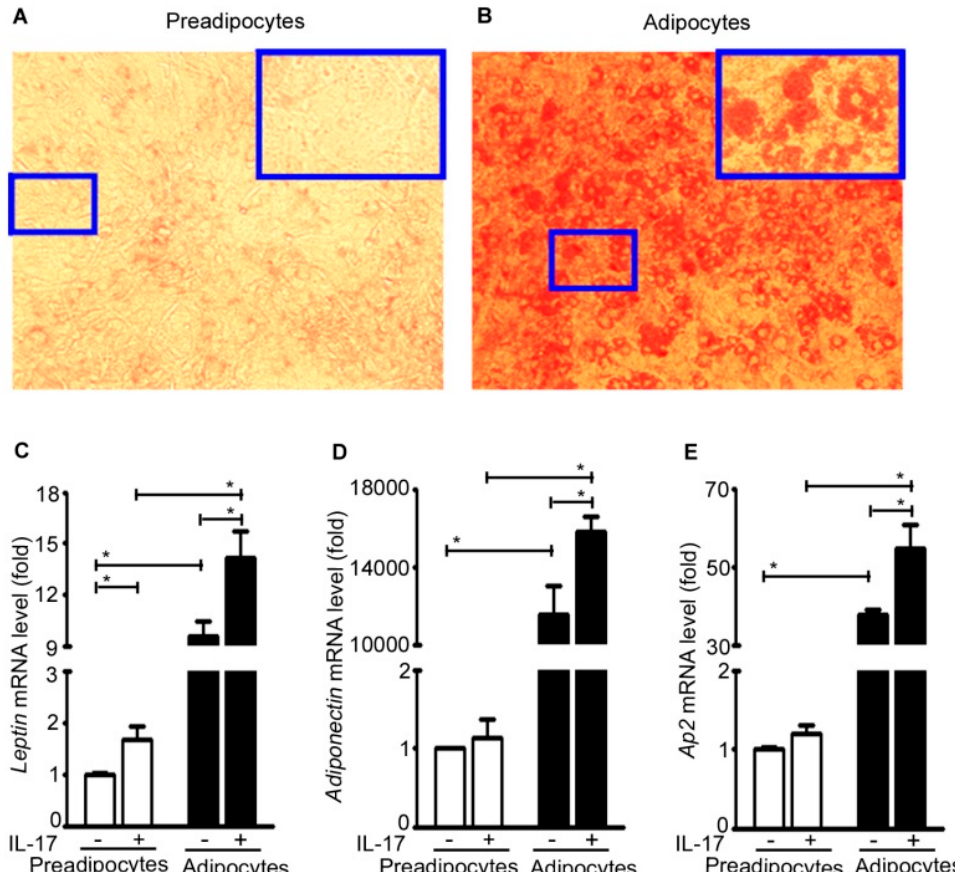
Figure 5. IL-17A induces adipokine expression in adipocytes. ( A , B ) Mouse 3T3-L1 pre-adipocytes were differentiated into mature adipocytes by 10-day differentiation culture; pictures are representatives of Oil Red O staining; original magnification, 100×, with the highlighted regions (small blue boxes) taken at 200× magnification (big blue boxes); ( C – E ) the pre-adipocytes and adipocytes were treated without ( − ) or with (+) 20 ng/mL IL-17A for 2 h; mRNA expression of each gene was analyzed with qRT-PCR; the pre-adipocytes without IL-17A treatment served as the basal level for comparison; data represent mean ± SEM (error bars) of six independent experiments ( n = 6 per group), * p < 0.05 between the indicated groups.